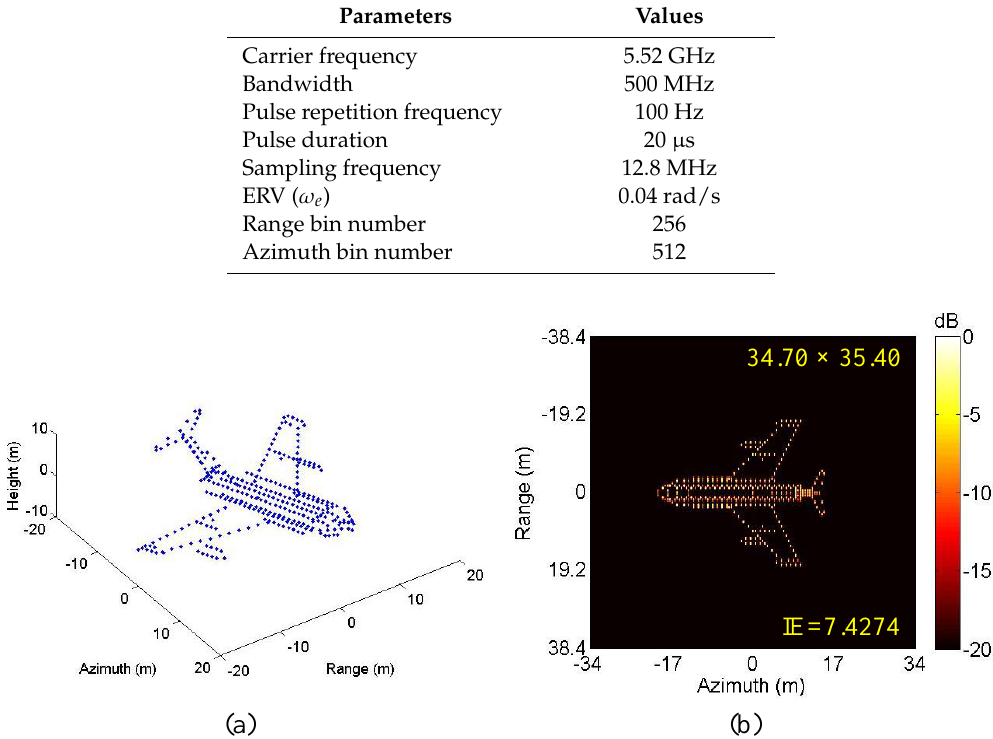
Figure 3. Simulated data of Yak-42 airplane. ( a ) 3-D scattering point model. ( b ) Standard ISAR